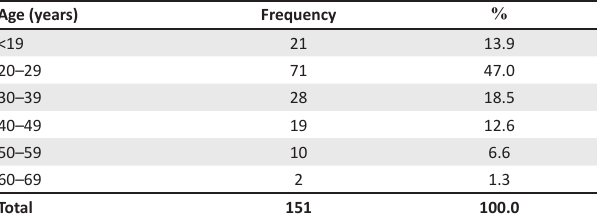
TABLE 1: Age distribution of patients with breast masses diagnosed as probably